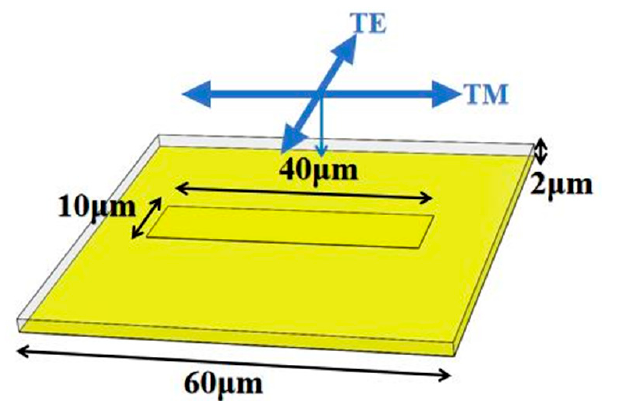
Figure 1. Schematic diagram of the composite metasurface structure. The rectangular structure is 40 µ m long and 10 µ m wide. The period of the structure is 60 µ m. The thickness of the medium is 2 μ m.